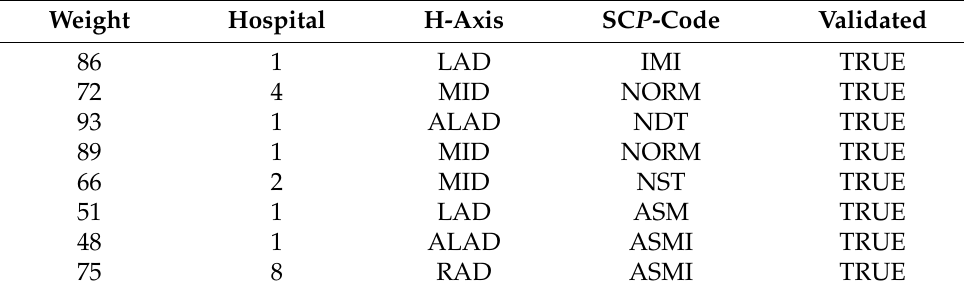
Table 10. l -diverse sliced males’ QIDs table.